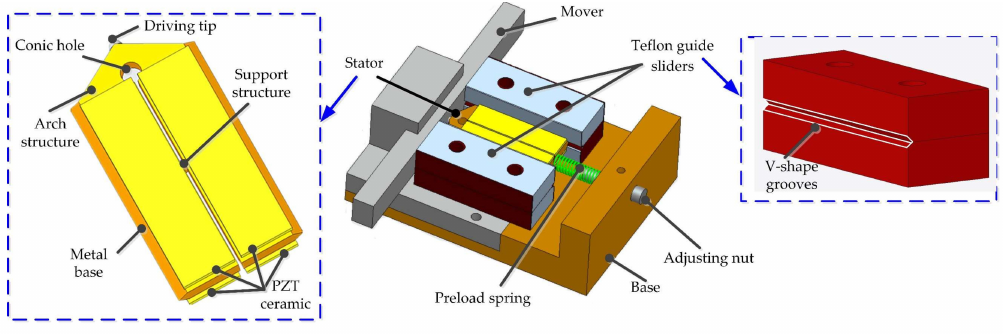
Figure 2. Construction of the